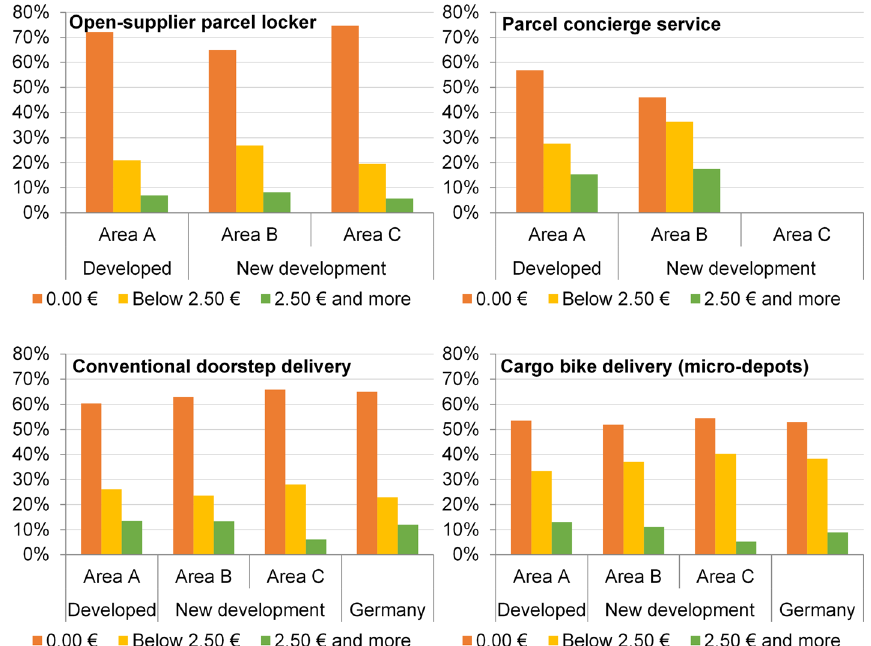
Fig. 8 Willingness to pay for the considered parcel delivery